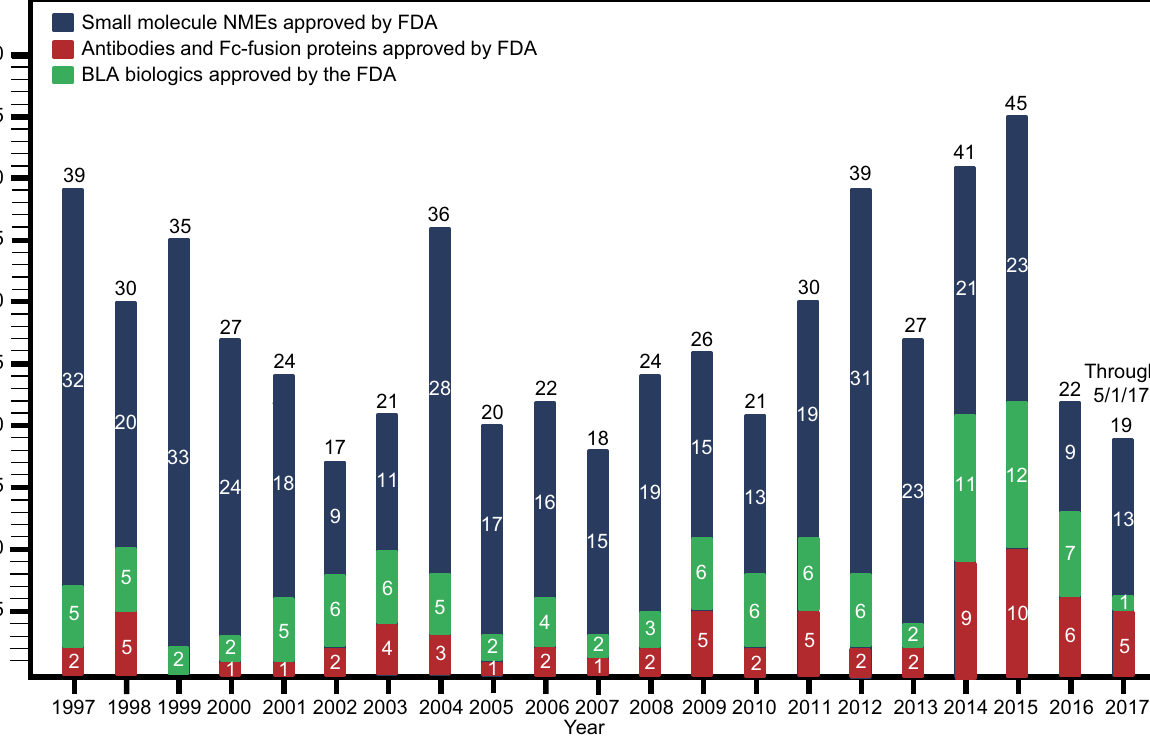
Figure 2. Small molecule drugs (blue lines), biologics including vaccines (green lines), and monoclonal antibodies/Fc fusion proteins (red lines) approved by the United States Food and Drug Administration from 1997 to May 1, 2017. This information was sourced and extracted from the US FDA website